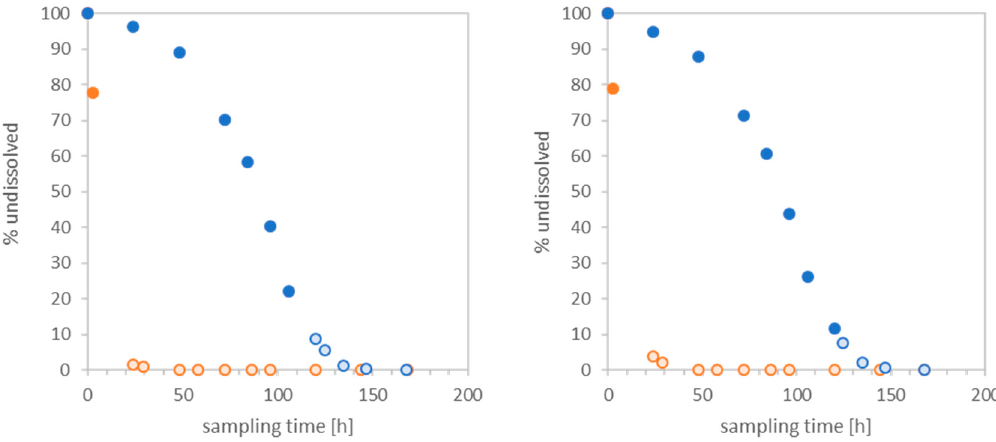
Figure 3. Dissolution rate depending on surface area and flow-rate. CuO (left) and ZnO NM111 (right). Blue curve indicates ascending and orange curve descending flow-rate ramping. Unfilled circles indicate points with low reliability due to remaining mass < 10%. Note the superimposed orange and blue dots.